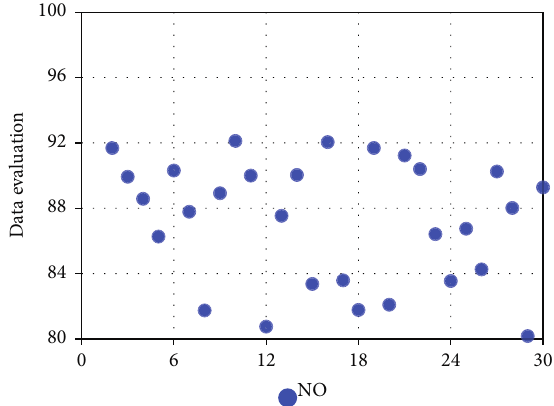
Figure 10: Statistical diagram of accounting data quality